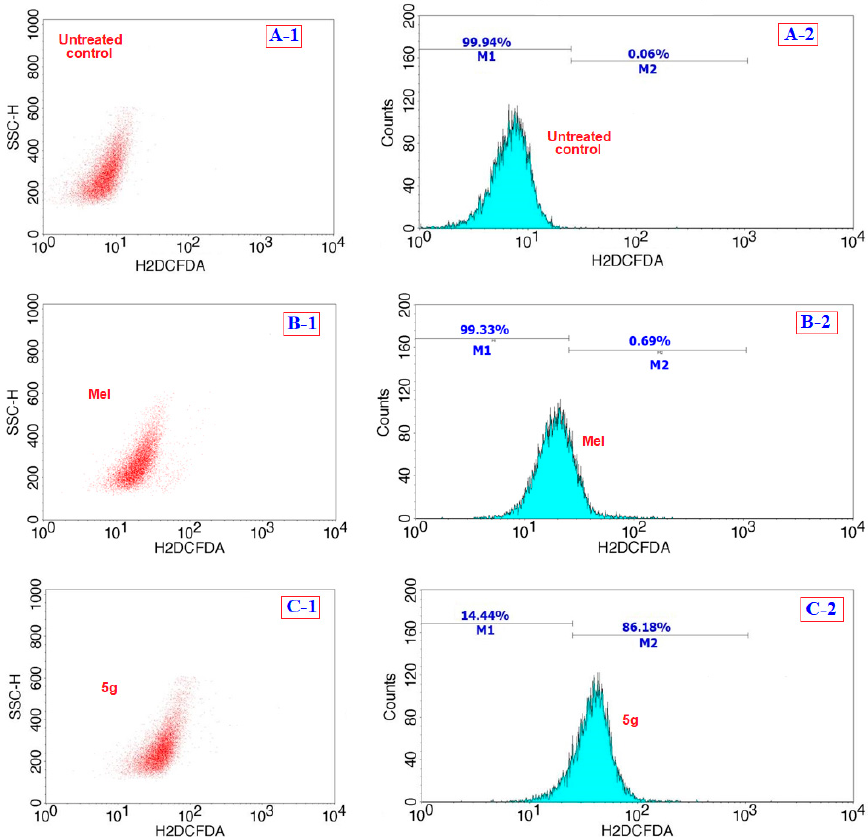
Figure 5. Comparison of flow cytometric analysis of the generation of reactive oxygen species (ROS) in HepG2 cells after treatment with the compound 5g ( C ) with that of the positive control Mel ( B ), and the negative control of cells without any treatment ( A ) over a period of 24 h.